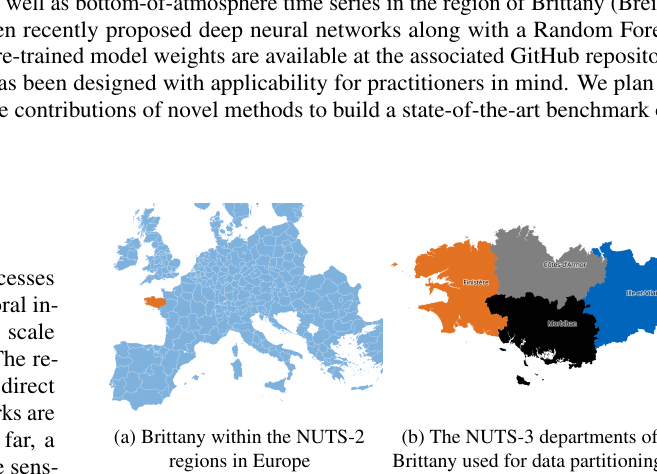
(b) The NUTS-3 departments of Brittany used for data partitioning. Figure 1. The NUTS-3 region FRH0 of Brittany,